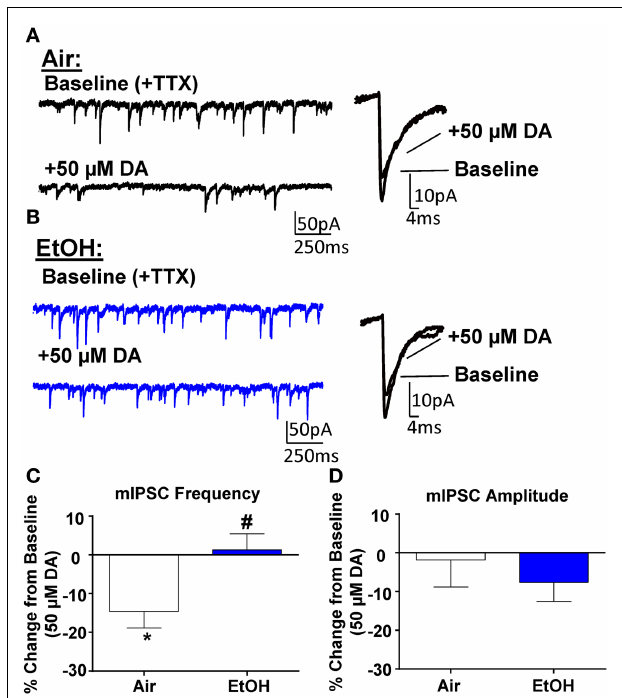
FIGURE 3 | Ethanol exposure impairs D3R-mediated suppression of GABA A receptor-mediated miniature inhibitory postsynaptic currents (mIPSCs) in the BLA . Exemplar compressed traces of mIPSC recordings obtained under Baseline conditions (in the presence of 1 µ MTTX) and in the presence of 50 µ M dopamine (DA) in slices from (A) Air- and (B) EtOH-exposed animals. Exemplar expanded scale traces of averaged mIPSCs are shown adjacent to these. (C) 50 µ M DA significantly decreased mIPSC frequency in Air animals (* p < 0.05 by one sample t -test compared to 0), but not in EtOH animals ( p > 0.05 by one sample t -test compared to 0).The DA-induced decrease in mIPSC frequency was significantly attenuated in EtOH compared to Air-exposed animals ( # p < 0.05 by unpaired t -test). (D) mIPSC amplitude was not altered by 50 µ M DA in either Air or EtOH-exposed animals. N = 8 animals from 6 Air and 5 EtOH